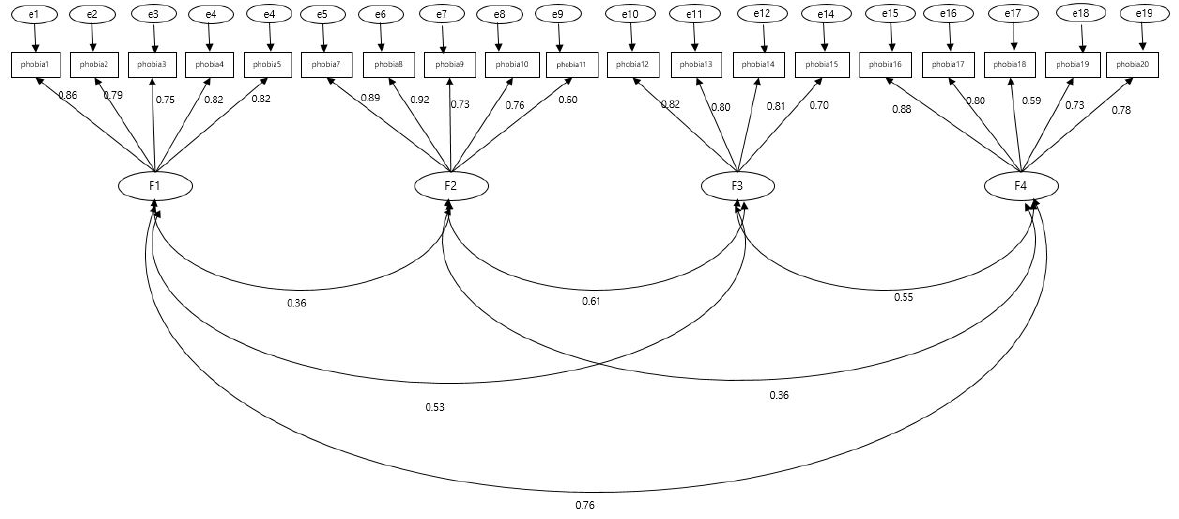
Figure 1. Confirmatory factor analysis (CFA).